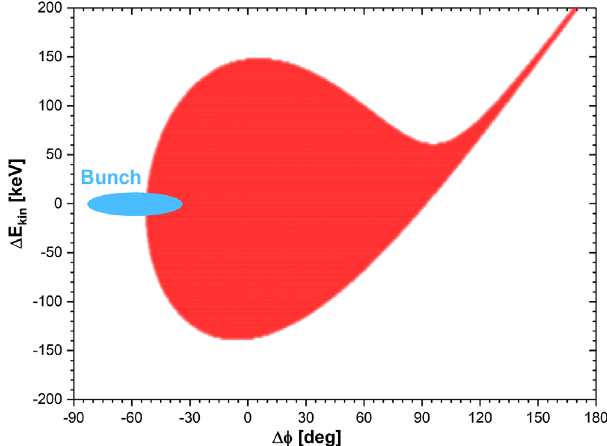
FIG. 2. The BPM amplitude vs Rb4 phase for one combination of the effective rf voltages. FIG. 3. DTL 1,2 longitudinal acceptance